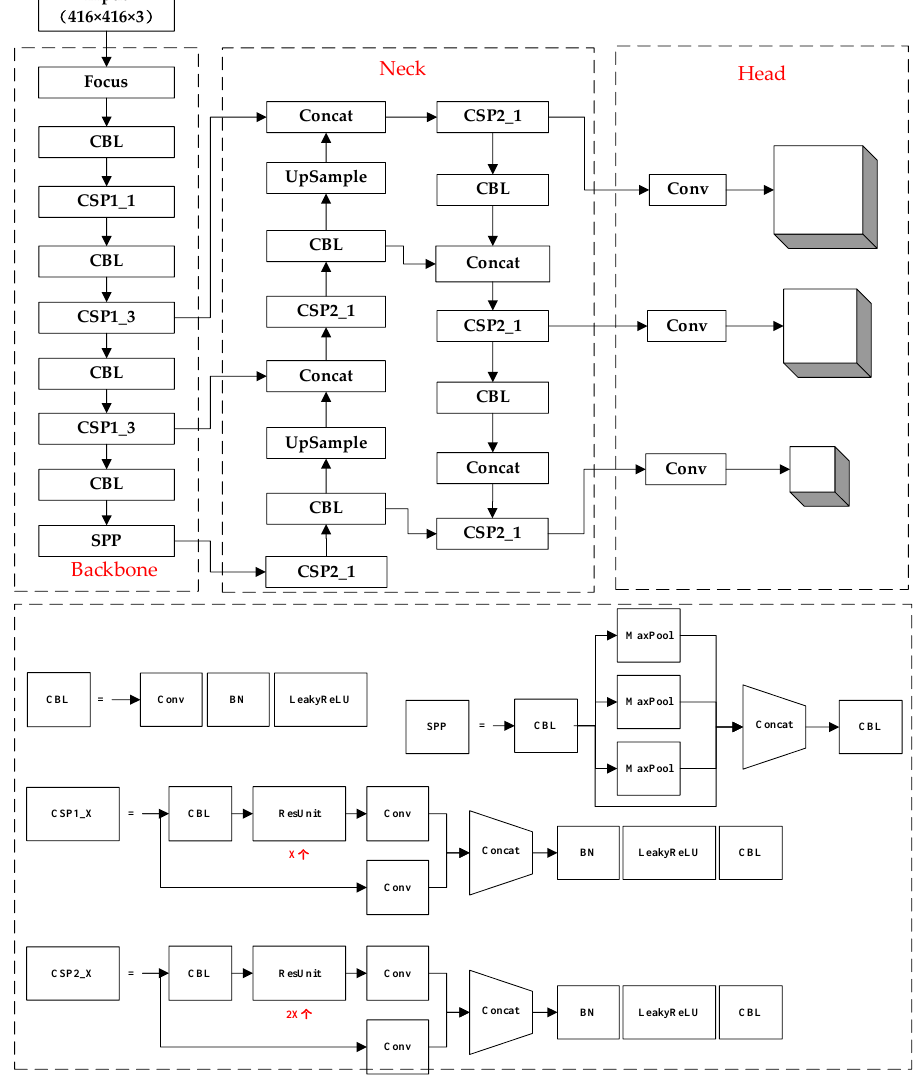
Figure 6. The network architecture of YOLOv5.